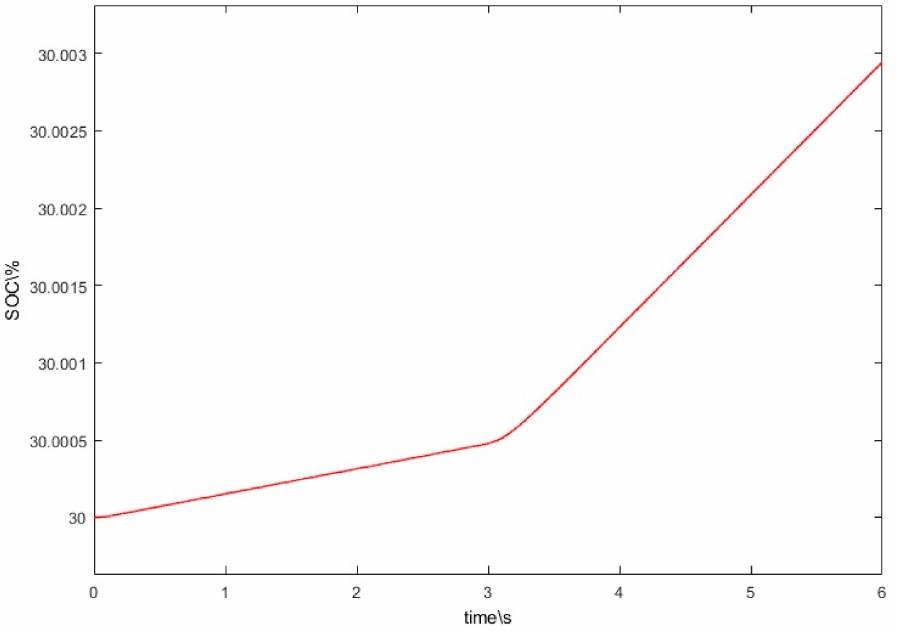
Figure 7. Time trend of the SOC percentage in the H 2 storage system for a supply power variation from its minimum value to its maximum value at 3 s.